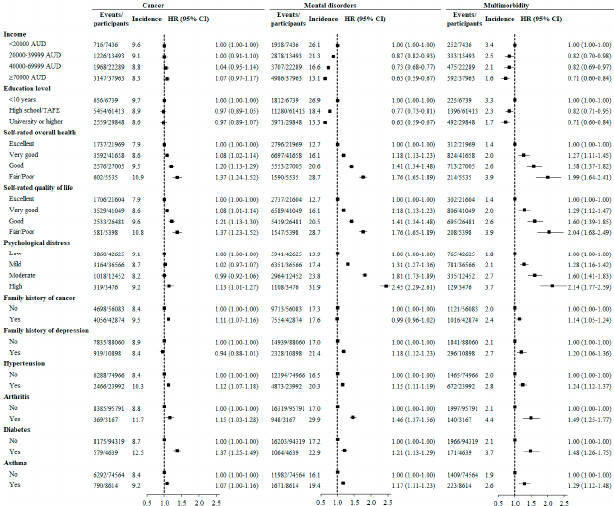
Figure 2. Hazard ratios for incident cancer, mental disorders, and multimorbidity associated with socioeconomic status, self-rated health and psychological distress, and history and family history of chronic conditions after multiple imputation of missing values in covariates. Hazard ratios (HRs) were assessed using Cox regression models adjusted for age, gender, the country of birth, income, education, work status, number of children, BMI, psychological distress, hypertension, dyslipidemia, diabetes, asthma, arthritis, hip replacement, and family history of cancer, depression, heart disease, stroke, diabetes, hypertension, Parkinson’s disease, and dementia. As a minimal difference in HRs (95% confidence intervals (CIs)) before and after multiple imputation of missing values in covariates was observed, we only present the results after multiple imputation in this figure.